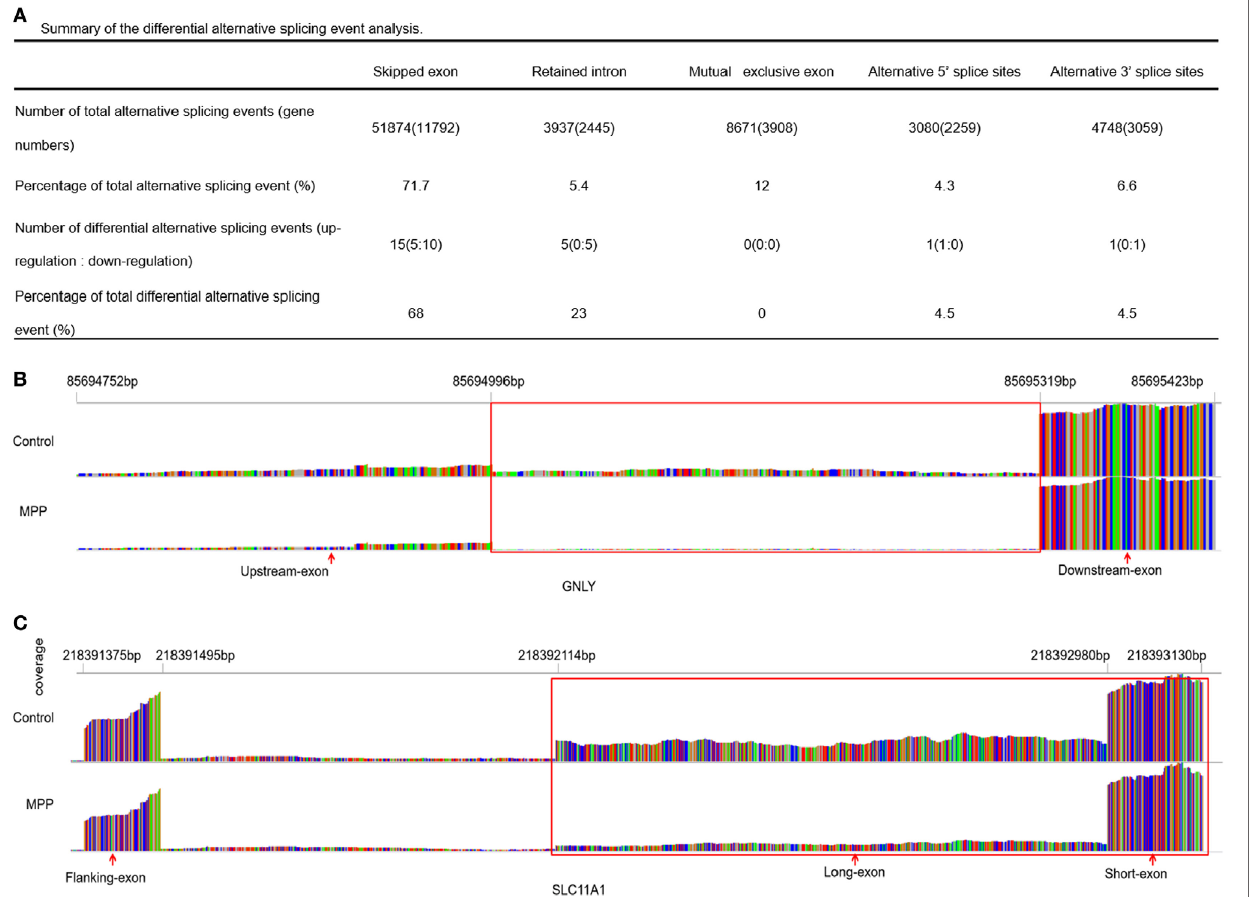
FigUre 7 | Differential alternative splicing events. (a) Summary of the differential alternative splicing event analysis results. (B) Read distribution plot for granulysin (GNLY) with differential isoform expression due to retained intron between Mycoplasma pneumoniae pneumonia (MPP) group and control group. (c) Read distribution plot for solute carrier family 11 (SLC11A1) with differential isoform expression due to alternative 3 ′ splice sites (A3SS) between MPP group and control